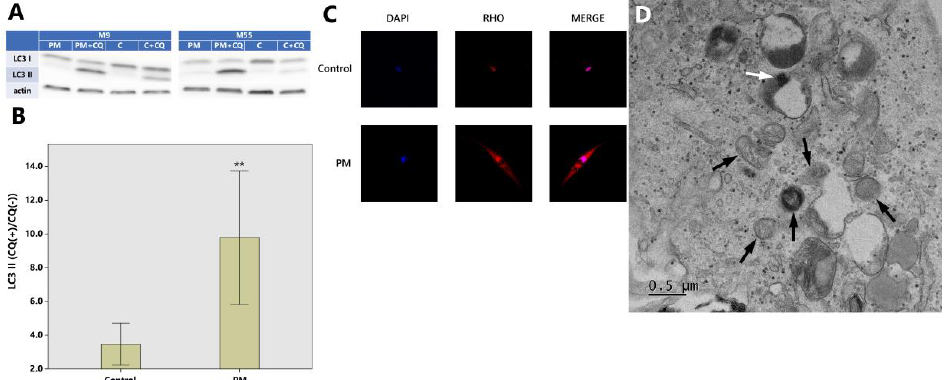
Figure 2. Autophagic degradation is increased in dermal fibroblasts exposed to PM 10 . ( A ) Cell lysates were subjected to SDS-PAGE (sodium dodecyl sulfate-polyacrylamide gel electrophoresis) and Western blotting; PM: particulate matter exposure, PM + CQ: particulate matter + chloroquine exposure, C: control (exposure to nothing), C + CQ: control + chloroquine; LC3: microtubule-associated proteins 1A/1B light chain 3B (a central protein in the autophagy pathway). ( B ) The ratio of LC3-II with and without chloroquine which represent autophagic activity (flux) are 3.47 ± 1.96 (control) and 9.78 ± 6.24 (PM) (Western blot analysis) (** p < 0.01). ( C ) LC3 puncta monitored from fluorescence microscopy are increased in PM 10 treated HDFs compared to control. Merged images were obtained with DAPI (4,6-diamidino-2-phenylindole) (nucleus; blue) and RHO (Alexa Fluor 594, Thermo Fischer Scientific Inc., Waltham, MA, USA) (LC3; red). The images were captured at 20 × magnification. ( D ) TEM photo shows deformed mitochondrias (black arrows) and PM internalization in the autolysosome (white arrow) in PM-exposed HDF. As for Western blot analysis, the images are representative of three independent experiments on n = 8 sample pairs (PM, control). LC3-II expression is normalized to actin (arbitrary units). Data are provided as mean ± SD. The statistical significance of difference between control and experimental data for autophagy was analyzed using the paired t -test. p -values < 0.05 were considered statistically significant. Statistical analysis of data was performed using SPSS for Windows software (version 15.0; SPSS Inc., Chicago, IL,